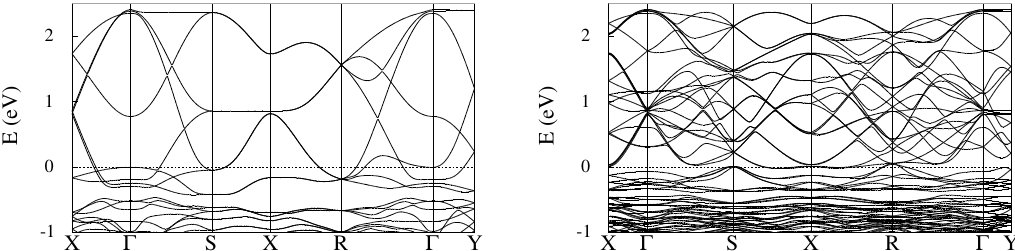
Figure 5: Calculated band structures of the nonmagnetic Pnma LaNiO the disproportionated antiferromagnetic P -type LaNiO agation wave vector ( 1 → Γ ( 0,0,0 ) → S ( 1 X ( 1 ,0,0 ) o 2